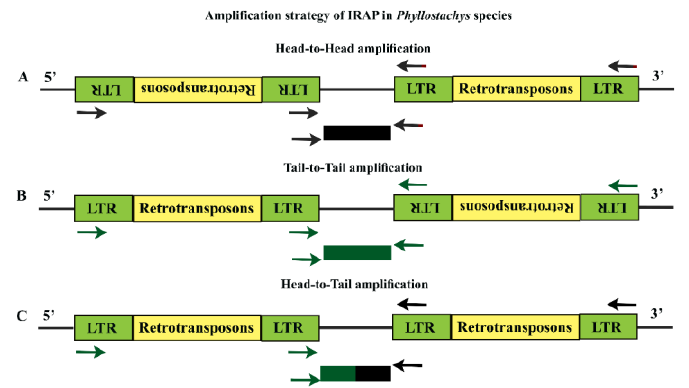
Figure 1. Amplificationstrategyforinterretrotransposonamplifiedpolymorphism(IRAP)in Phyllostachys species (Asian bamboo). LTR stands for long terminal repeat. The single primer acts as both forward and reverse primer in PCR reaction. ( A ), Head-to-Head amplification; ( B ), Tail-to-Tail amplification; ( C ), Head-to-Tail amplification. The arrows and rectangles show the position of the IRAP primers and expected PCR products,